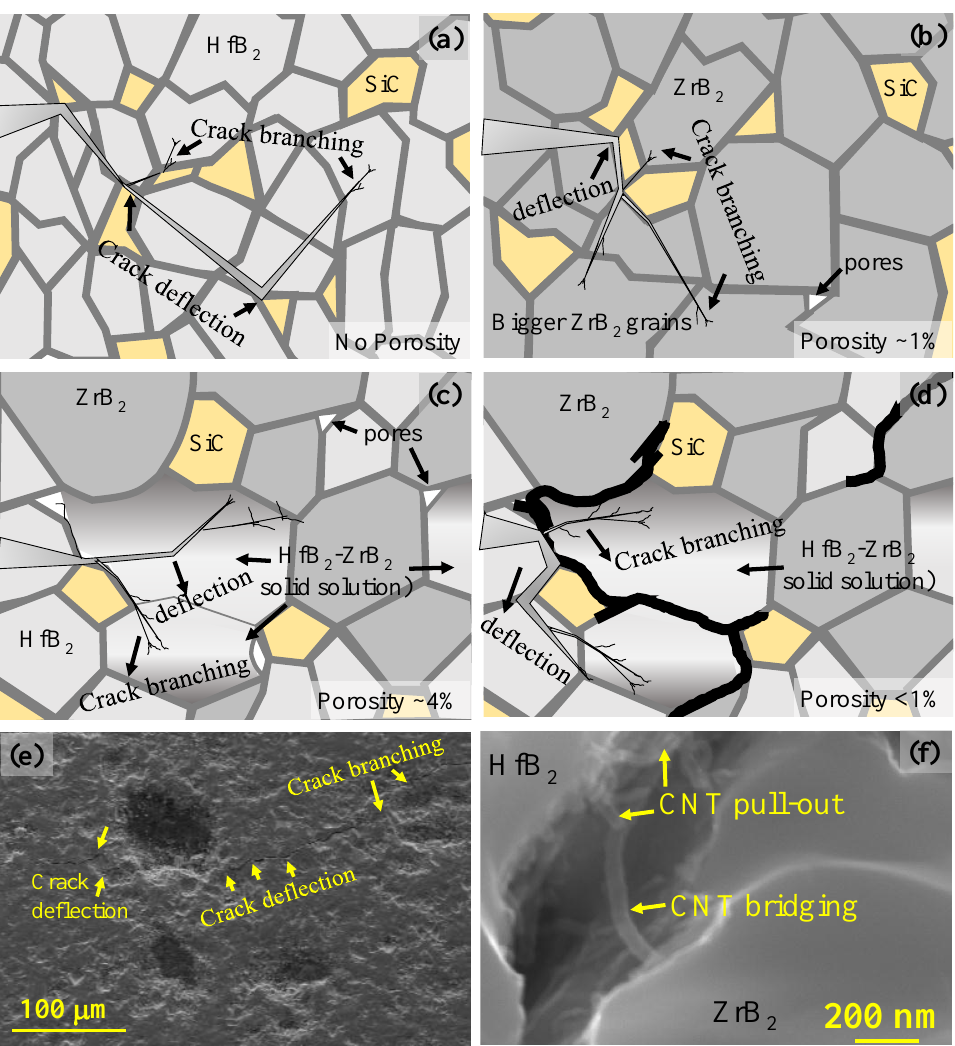
Figure 7. Schematic illustrating the effect of microstructural evolution on the fracture toughness of HfB2-ZrB2-SiC-CNT: ( a ) H20S, ( b ) Z20S, ( c ) HZ20S and ( d ) HZ20S6C composites.